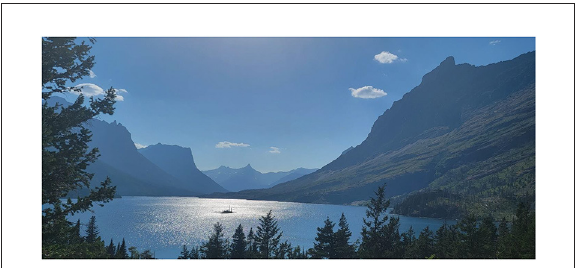
FIGURE1 Saint Mary Lake with a view of the Wild Goose Island in Glacier National Park, Montana, USA. Climate variability and change are beginning to have noticeable impacts on the glaciers with implications for regional freshwater and ecosystems. Photo credit: Debashree Bagchi Ganguly. Date: 18th August, 2022